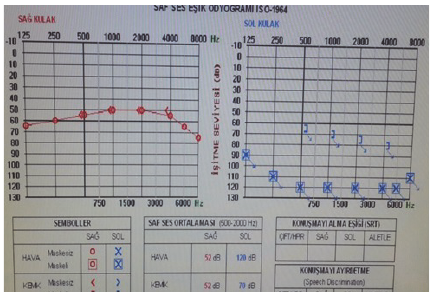
Figure 1: Pure tone audiogram of the patient at first admission was presented.